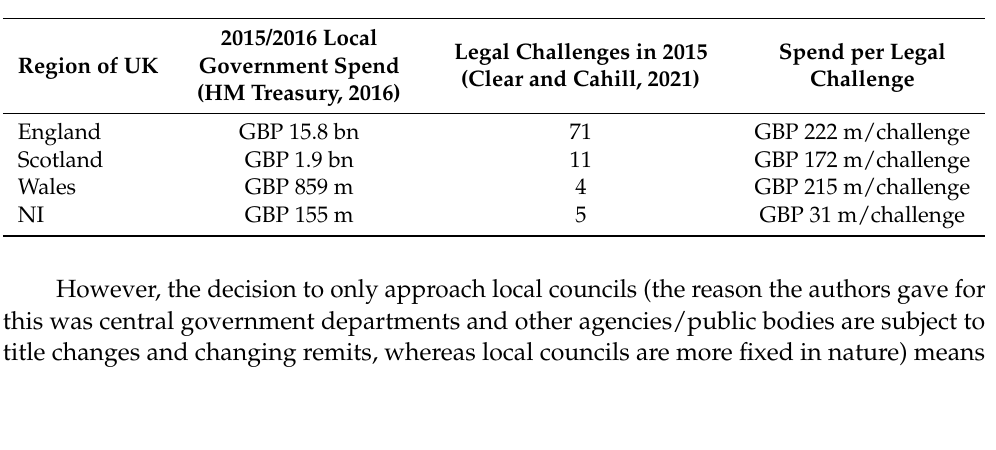
Table 2. Local government spend and number of legal challenges across the UK.